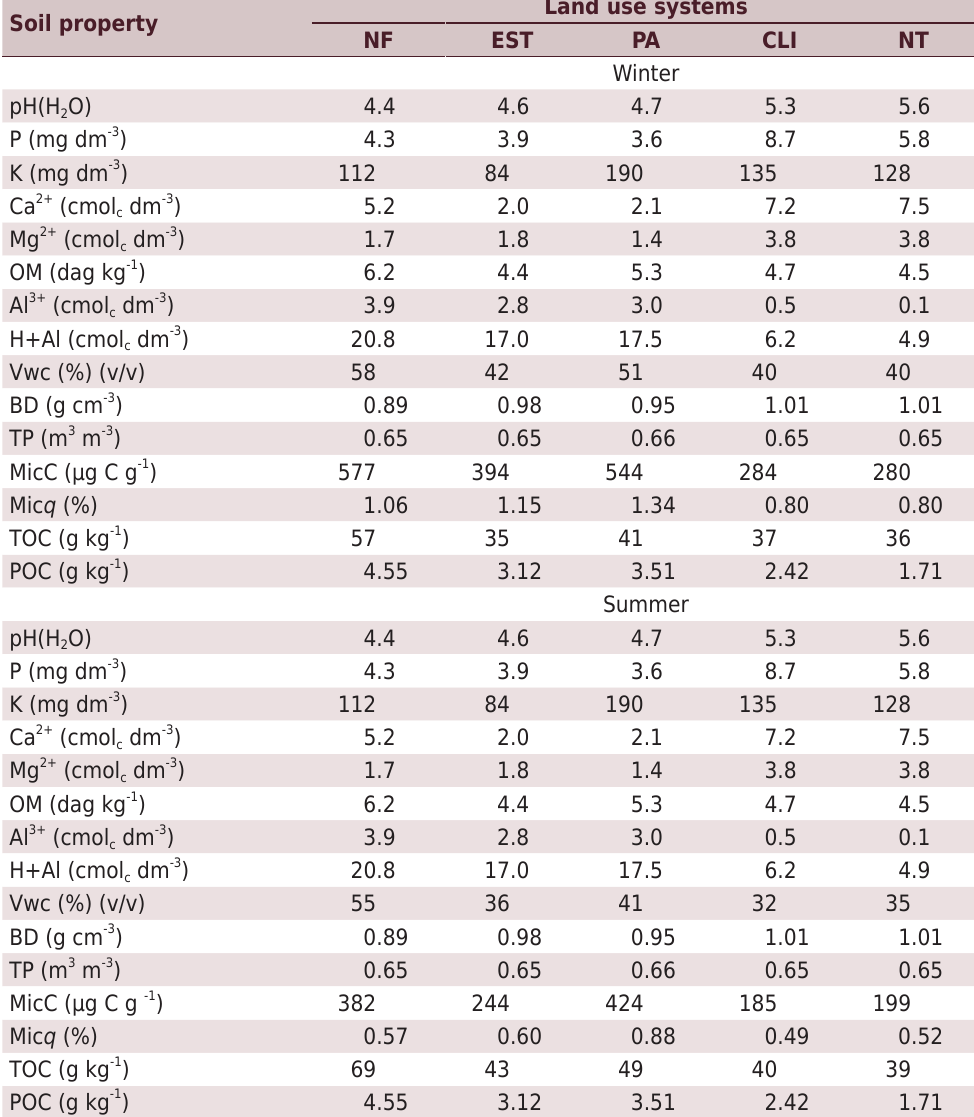
Table 4. Soil chemical, physical, and microbiological properties in the 0.00-0.20 m layer, in native forest (NF), Eucalyptus stands (EST), perennial pasture (PA), crop-livestock integration (CLI), and no-tillage (NT) systems on the Southern Santa Catarina Plateau Soil